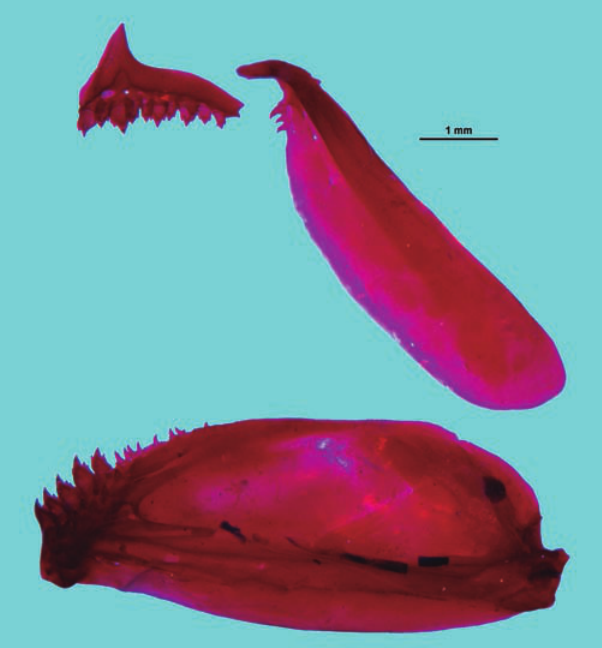
Fig. 2. Tetragonopterus akamai , UNT 464, paratype, 46.5 mm SL. Left side of premaxilla, maxilla, and lower jaw. Scale bar = 1